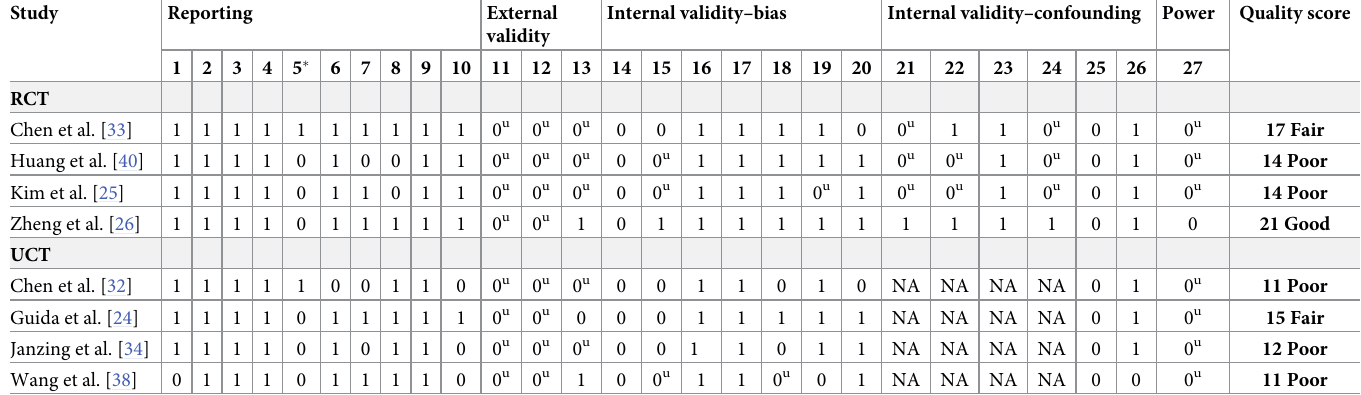
printed circular WHO (PRWE-pain: mean difference (MD) 19.7; VAS: MD 5.48, p < 0.001) [24]. In Janzing’s UCT, two of three participants had complete pain relief on the 100mm VAS after five weeks of immobilization with the 3D-printed 3-point WHO, while the third partici- pant reported pain increase caused by a pressure point [34]. Table 3. Critical appraisal of